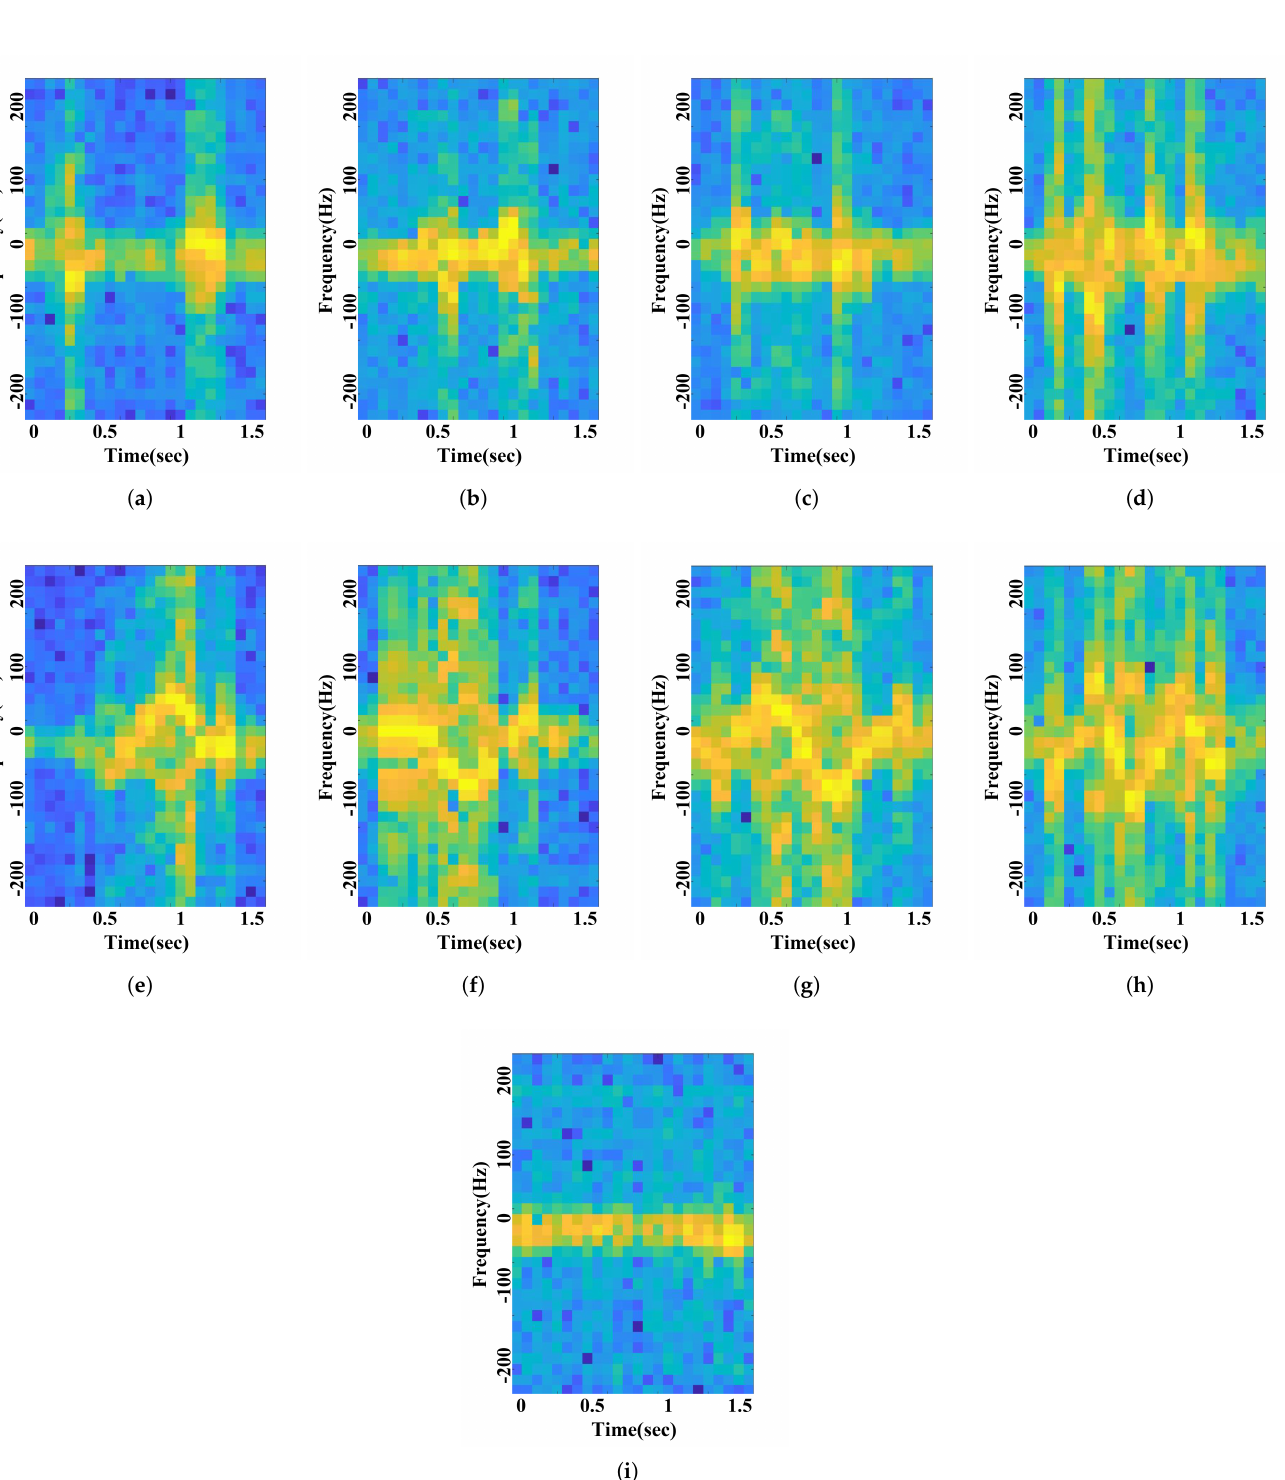
Figure 5. Gesture spectrogram: ( a ) right; ( b ) left; ( c ) yes; ( d ) no; ( e ) stop; ( f ) pull; ( g ) once; ( h ) twice; ( i )